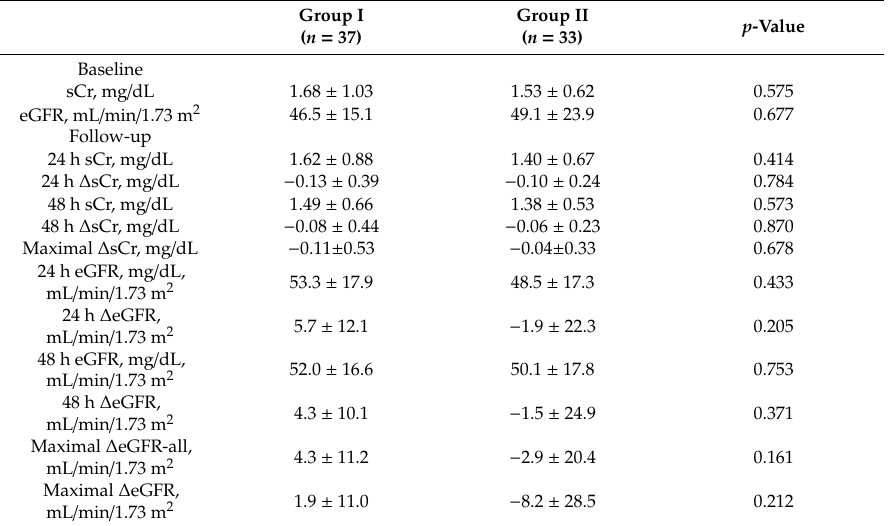
Table 2. Biochemical characteristics of patients before and after coronary